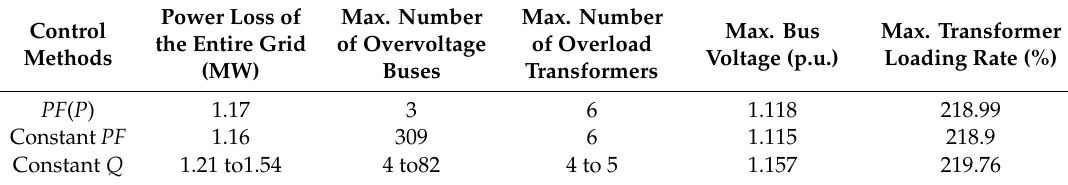
Table 2. The summary of the case studies with the base case (photovoltaic (PV) penetration level of 22%).